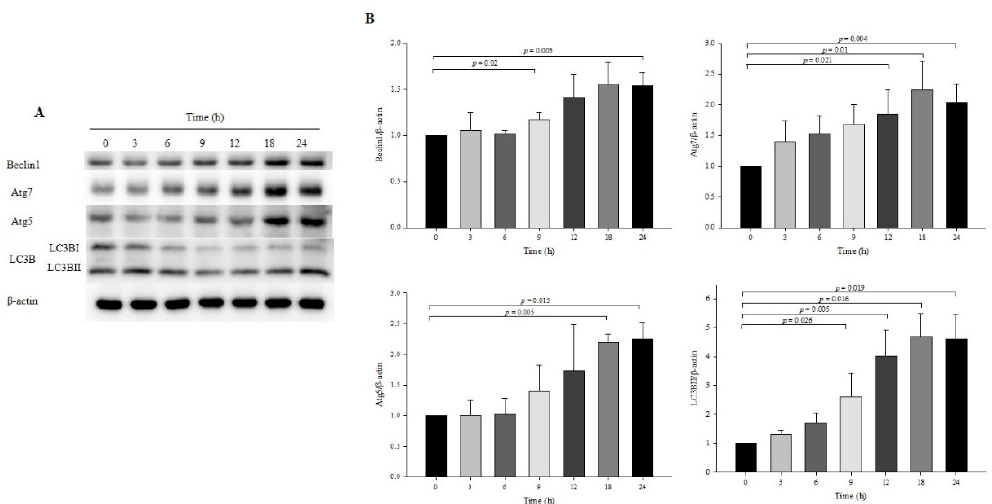
Figure 2. Effect of OXY on autophagy development at various time points. Cells were treated with 10 µ g / mL OXY, and expression levels of autophagy-associated proteins (Beclin-1, Atg7, Atg5, and LC3B-II) were determined by Western blotting ( A ) and quantified ( B ). From each lysate, equal amounts of protein were loaded on a separate gel, blotted for actin and this signal was used for determining the ratio protein of interest / actin as displayed in the figure. The cropped blots are representative of three independent experiments. The full-length blots are shown in Supplementary Figure S1. Each value indicates the mean ± SD of three independent experiments performed.